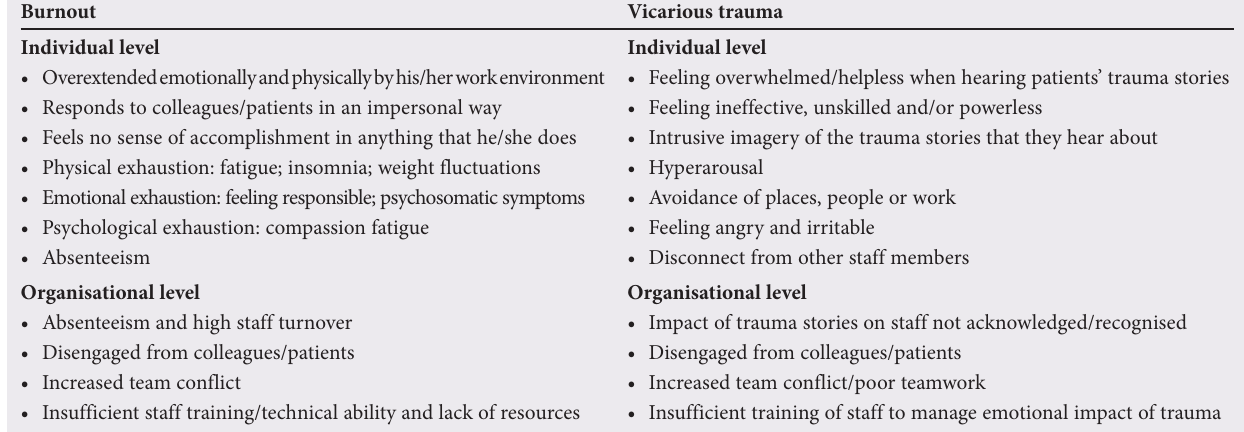
Table 6. Symptoms of HCW burnout and vicarious trauma Burnout Individual